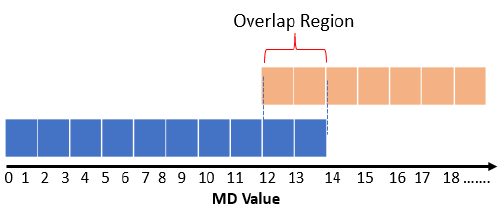
Figure 3. Illustration on ω determination when normal and abnormal Mahalanobis Distances (MDs) are overlapped.